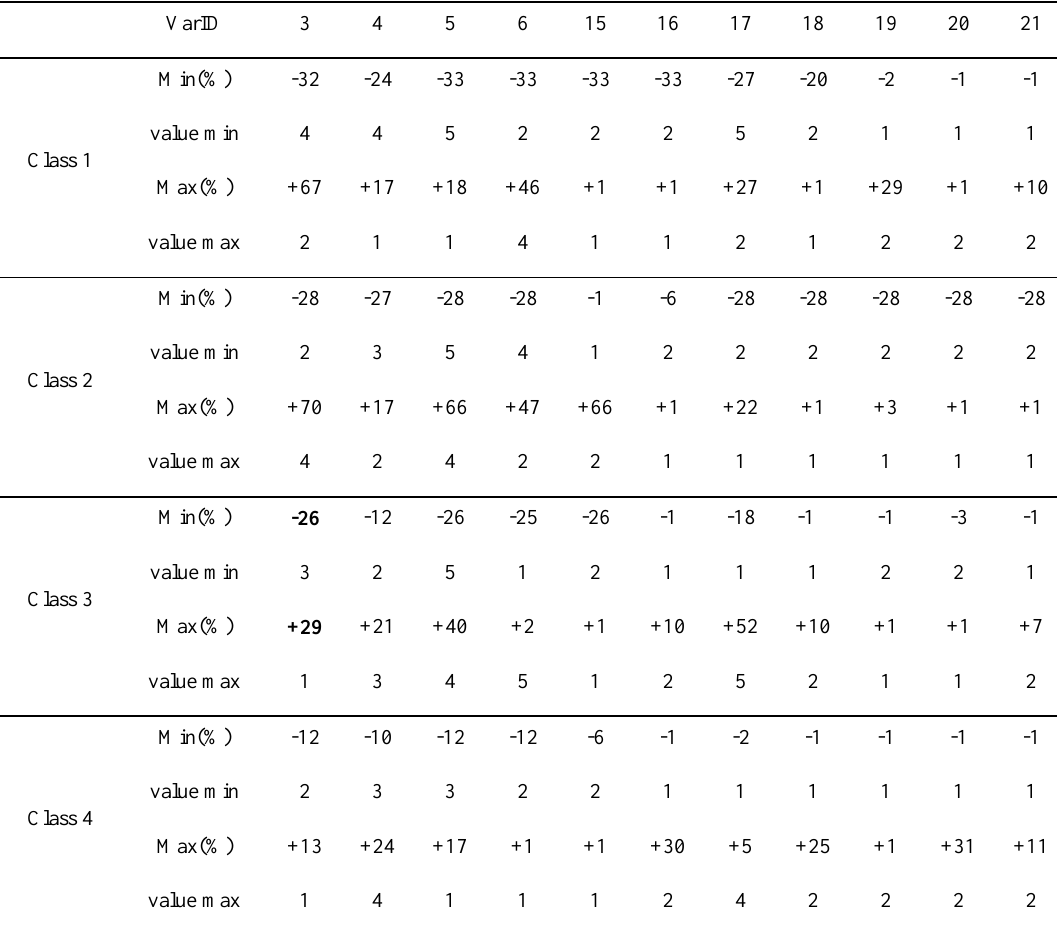
Table 3. Sensitivity Analysis of